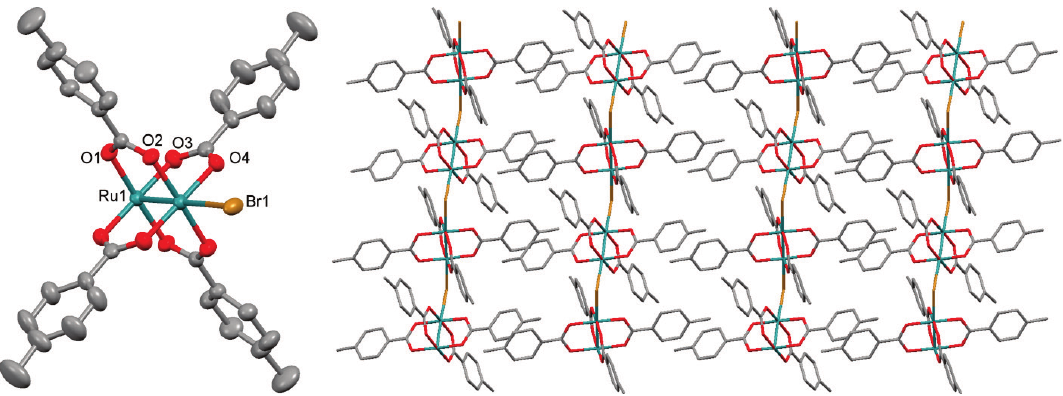
Figure 3. Left : thermal-ellipsoid representation of two paddlewheel units of 3 (50% probability ellipsoids); Right : packing of zigzag chains. Hydrogen atoms are omitted in both cases for